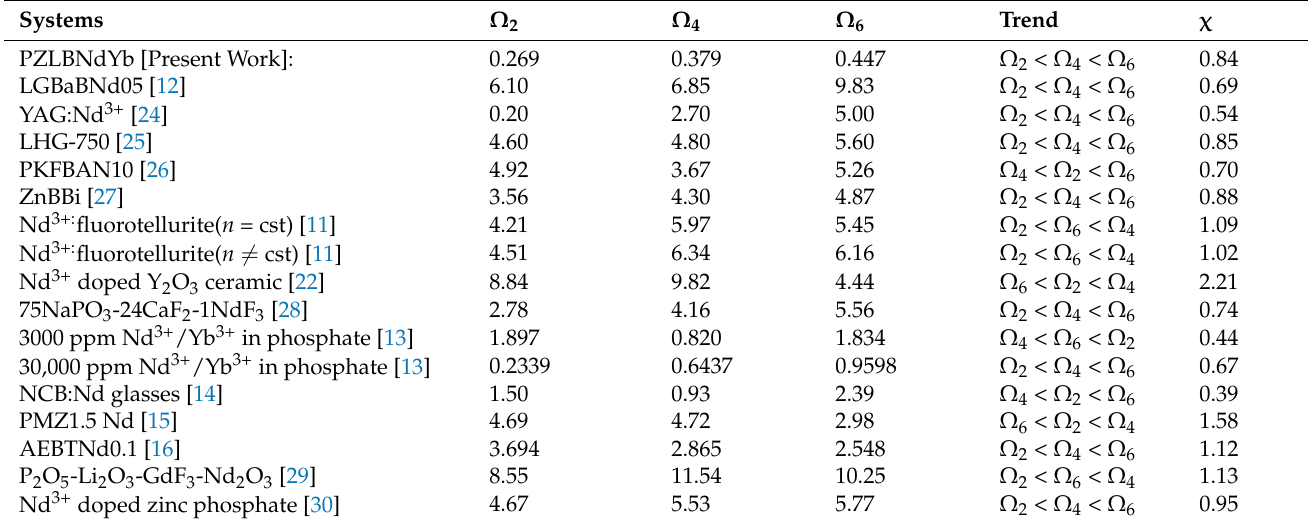
Table 2. Comparison of Judd–Ofelt parameters ( Ω t , × 10 − 20 cm 2 ) of PZLBPr glass along with other